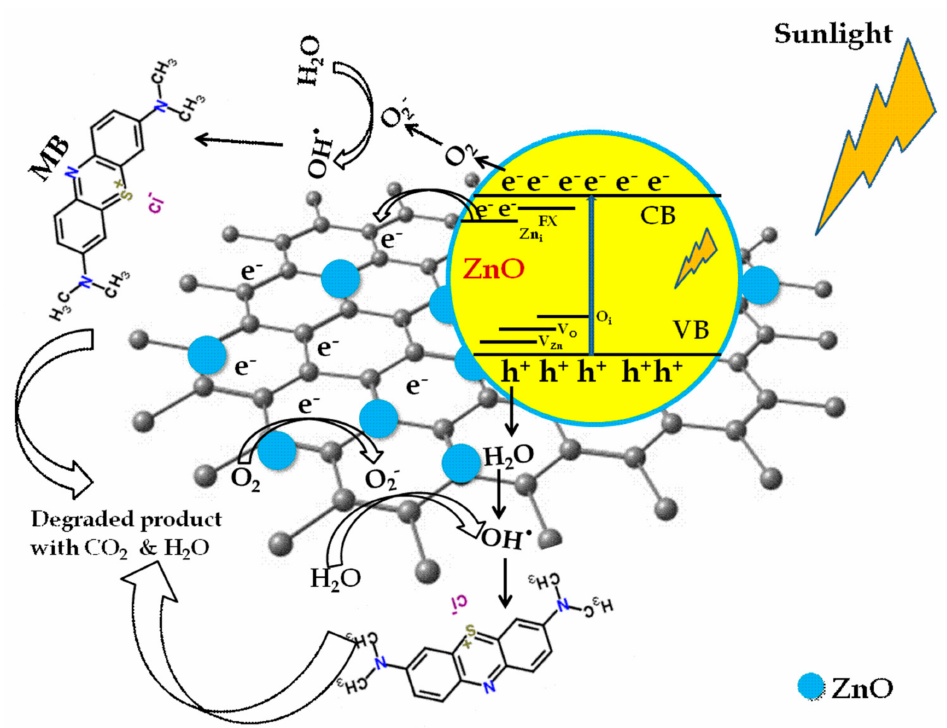
Figure 7. Schematic diagram of photocatalytic degradation mechanism of ZnO/graphene